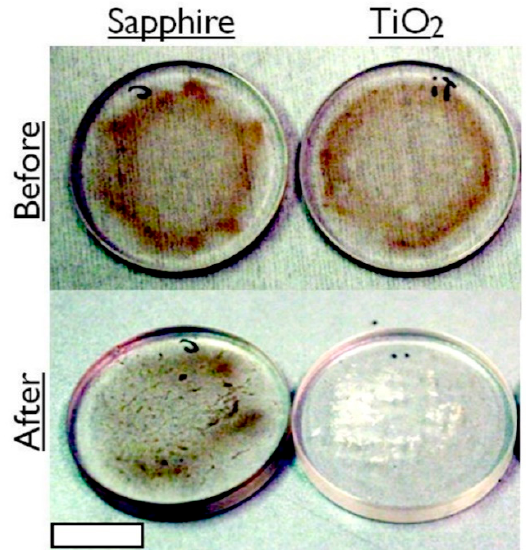
Figure 3. Photographs of a standard sapphire window and a UV-exposed TiO 2 coated window spin coated at 3k rpm with dead North Sea crude oil (API 35), before and after 21 h of submergence in flowing water. Scale bar = 10 mm.